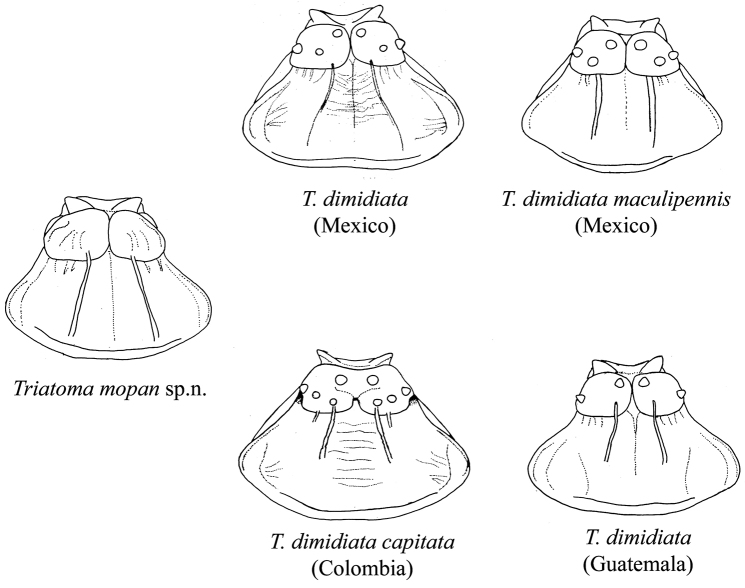
Drawings of the pronotum of T.
mopan and distinct T.
dimidiata morphotypes. Note that for T.
dimidiata the anterior lobe shows discal and lateral tubercles, that are absent in T.
mopan, which also presents a shorter and rounder anterolateral angle. Drawings by Carolina Dale.